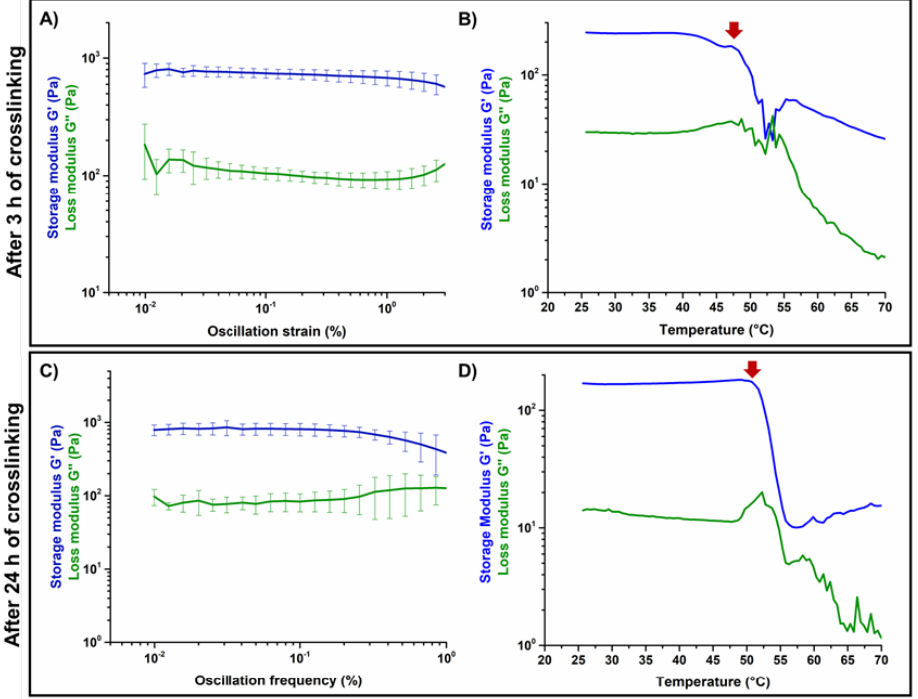
Amplitude sweep test ( A , C ) and temperature ramps ( B , D ) performed on GEN-Coll/nanoHA after 3 h and 24 h of incubation at 37 °C.